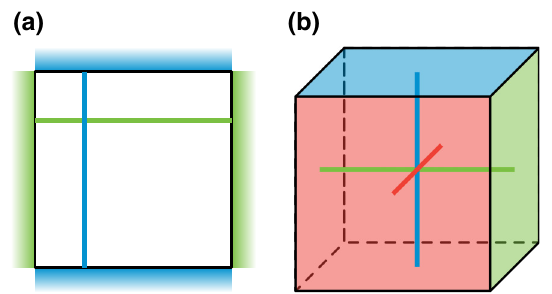
FIG. 6. Hypercubic color codes are defined on lattices that tes- sellate the hypercube, where opposite boundaries have the same color. (a) The d = 2 case. Logical X 1 and Z 2 are supported on the green line (as products of X and Z operators, respectively). Sim- ilarly, X 2 and Z 1 are supported on the blue line. (b) The d = 3 case. Logical X operators are supported on the boundaries and the corresponding logical Z operators connect boundaries of the same